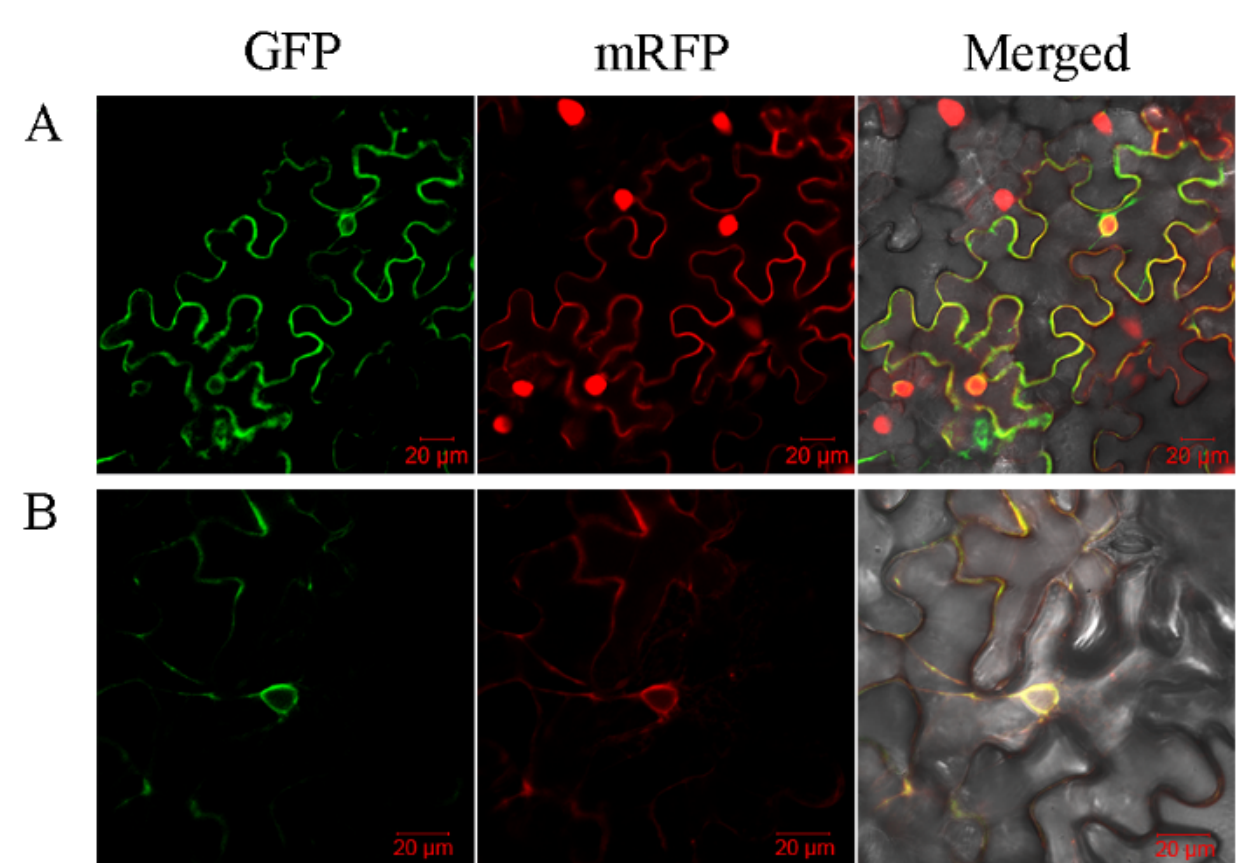
Figure 5. Subcellular localization of SbPht1;8. ( A ) SbPht1;8-GFP fluorescence signal overlapped with those of the mRFP nucleus and cell membrane markers; ( B ) SbPht1;8-GFP fluorescence signals overlapped with those of the mRFP endoplasmic reticulum and cell membrane markers.